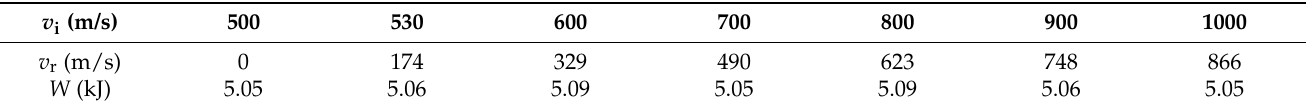
Table 9. Results of calculated work W in the perforation.